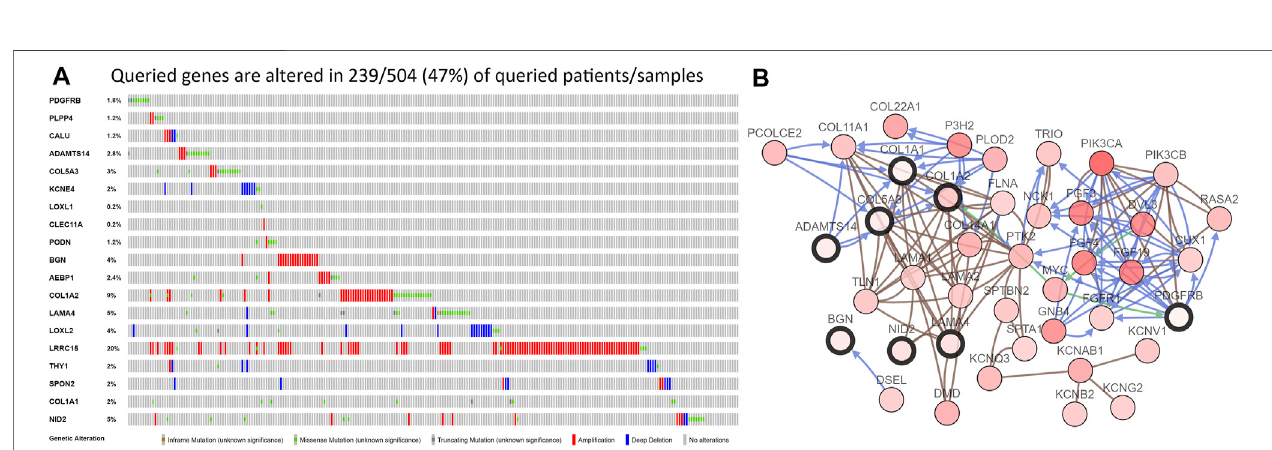
FIGURE4| TheresultsofthecBioPortalanalysis. (A) .The20keygenesweremodi fi edin239of504(47%)HNSCCpatientsandampli fi cationisthemostcommon modi fi cations type in HNSCC; (B) . The neighbor genes ’ biological interaction network of these 20 stemness-related genes in HNSCC.